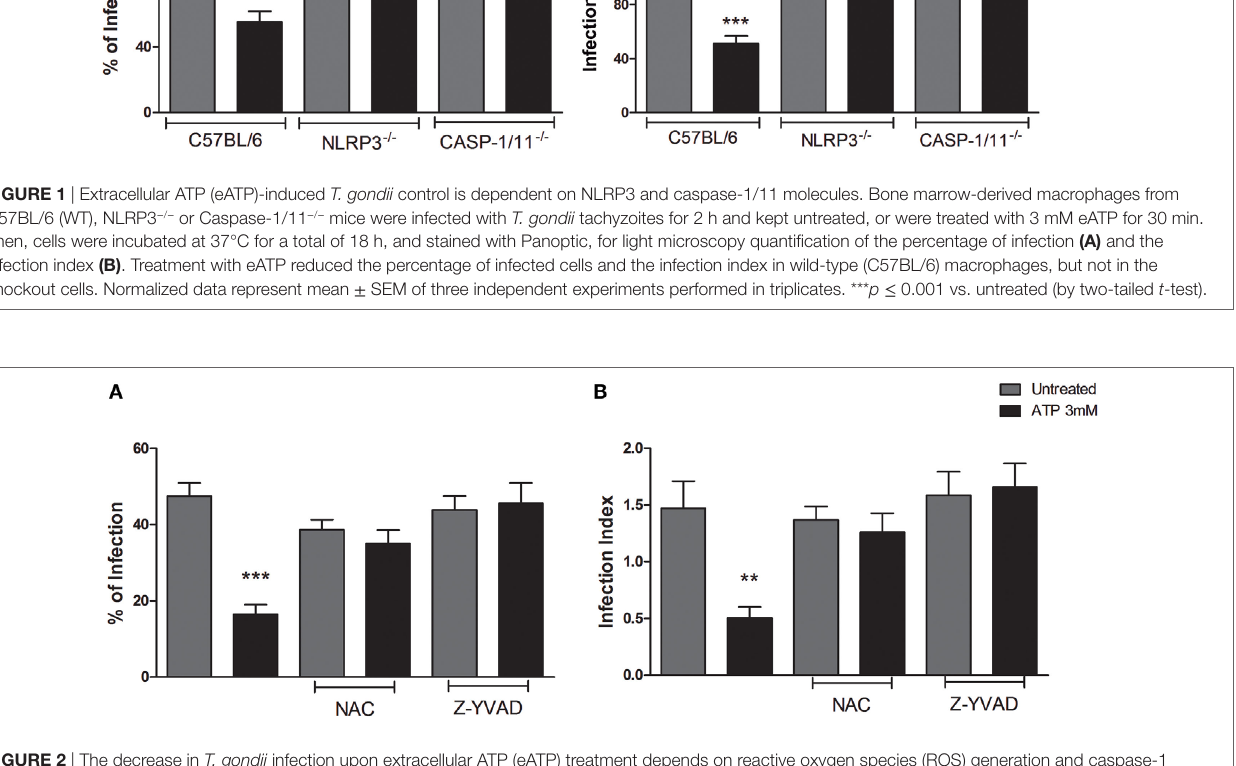
FigUre 2 | The decrease in T. gondii infection upon extracellular ATP (eATP) treatment depends on reactive oxygen species (ROS) generation and caspase-1 activation. Wild-type (C57BL/6) bone marrow-derived macrophages were infected with T. gondii tachyzoites for 2 h and then left untreated, or subjected to one of the following treatments: 10 mM N -acetyl cysteine (NAC) or 2 µM Z-YVAD for 30 min followed by 3 mM eATP, for 30 min. After treatments, cells were incubated for a further 18 h at 37°C, and stained with Panoptic, for light microscopy quantification of the percentage of infection (a) and the infection index (B) . Treatment with NAD or Z-YVAD before exposure to eATP prevented the eATP-dependent reduction in T. gondii infection. Data represent mean ± SEM of three independent experiments performed in triplicates. ** p ≤ 0.01 and *** p ≤ 0.001 vs. untreated (by one-way ANOVA followed by Tukey’s test).